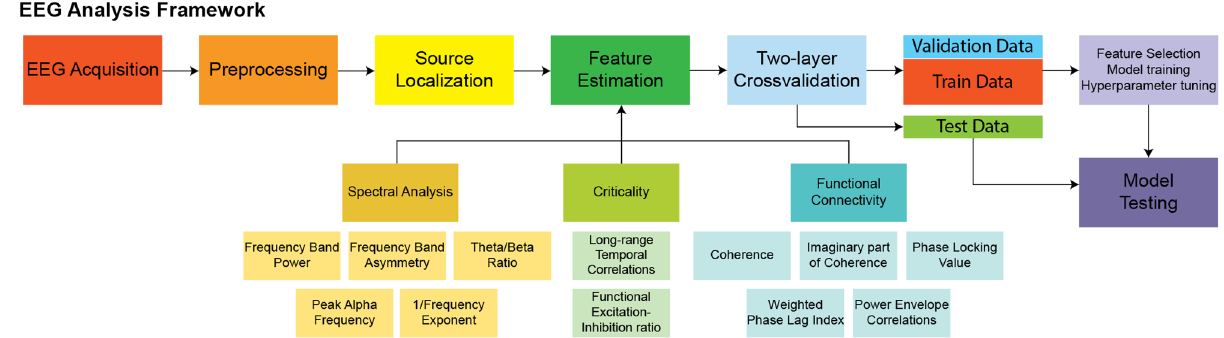
Figure 1. Overview of the EEG analysis framework. The EEG data was preprocessed and source modelled, followed by estimation of commonly used EEG biomarkers. Repeated 10-by-10 two-layer cross-validation was performed to split the data. Feature selection, model training and hyperparameter tuning were performed on the inner fold training and validation set, while the generalization performance was evaluated on the entirely unseen test set. Logistic regression, random forest, and support vector machine were employed to classify